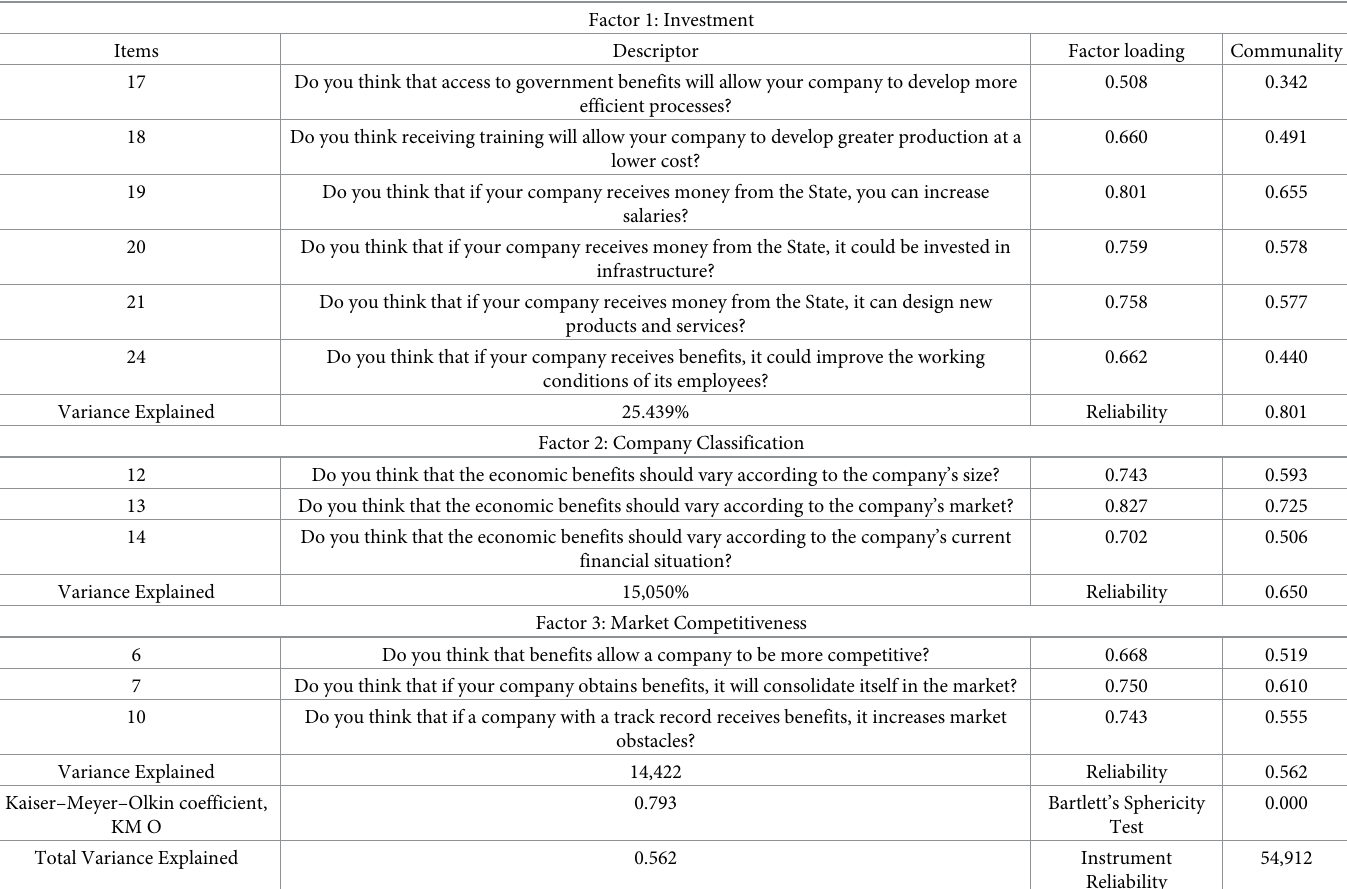
Table 2. Perception factors of the state support program for companies.